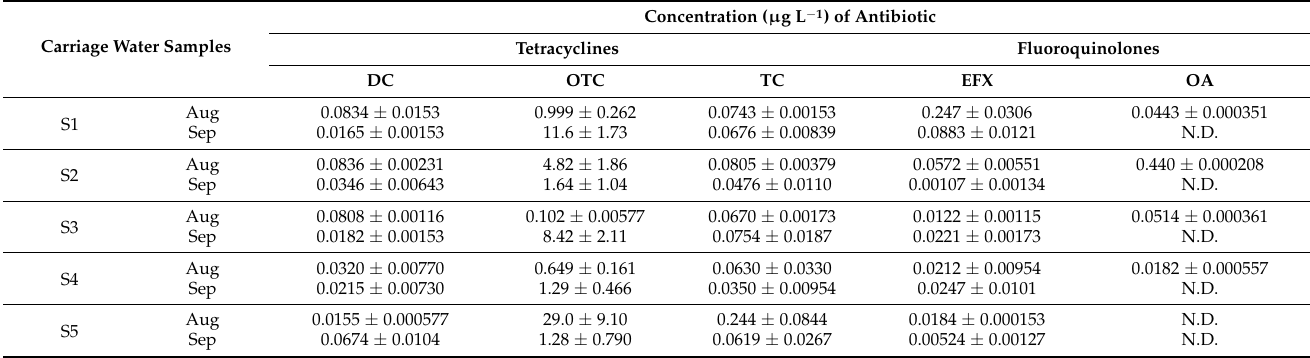
Table 1. The concentrations of antibiotics detected in carriage water samples collected from Goldfish Market in two months (mean ± SD, n = 15).